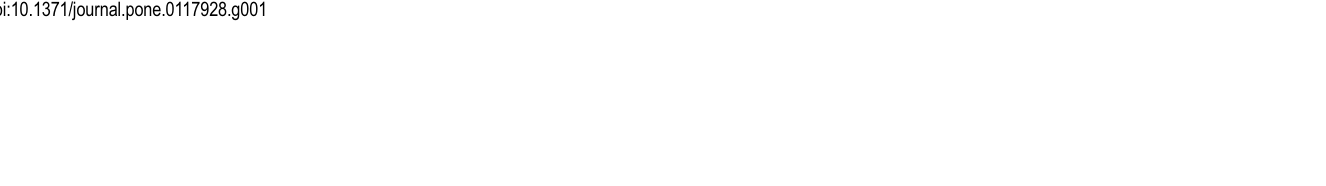
PLOS ONE | DOI:10.1371/journal.pone.0117928 February 23,